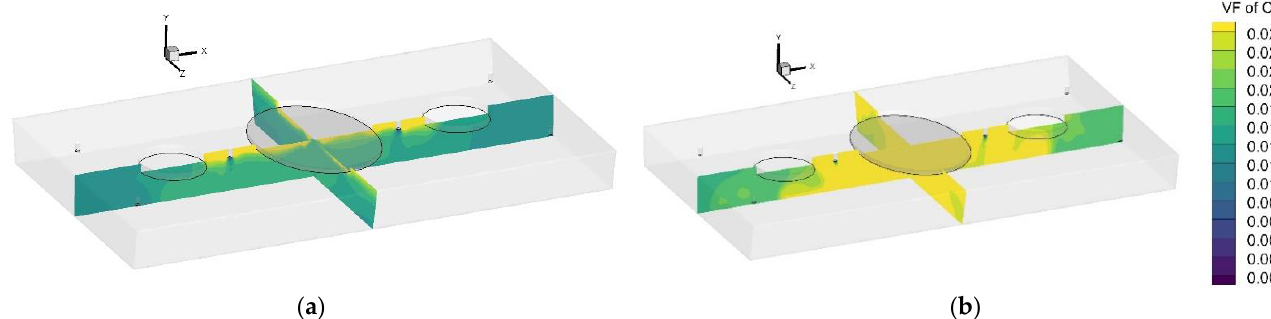
Figure 8. Variation of oxygen volume fraction with time for different argon flow rates ( a ) and effect of argon flow rate on volume fraction of oxygen for different times ( b ) in an isolated injecting chamber.